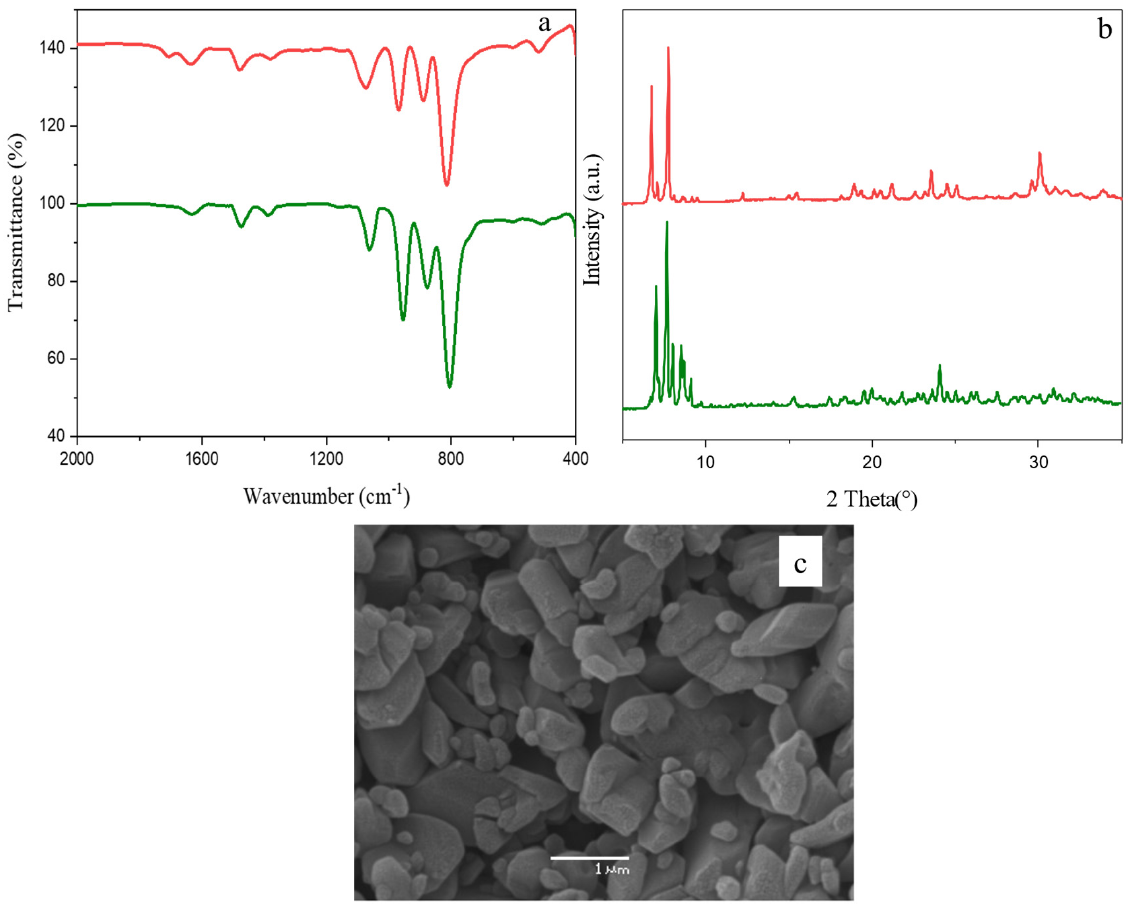
Figure 10. FT-IR ( a ) and XRD ( b ) spectra of reused (red line) and fresh (green line) (TBA) 5 PMoV 2 catalyst; ( c ) SEM micrography of the reused (TBA) 5 PMoV 2 catalyst.